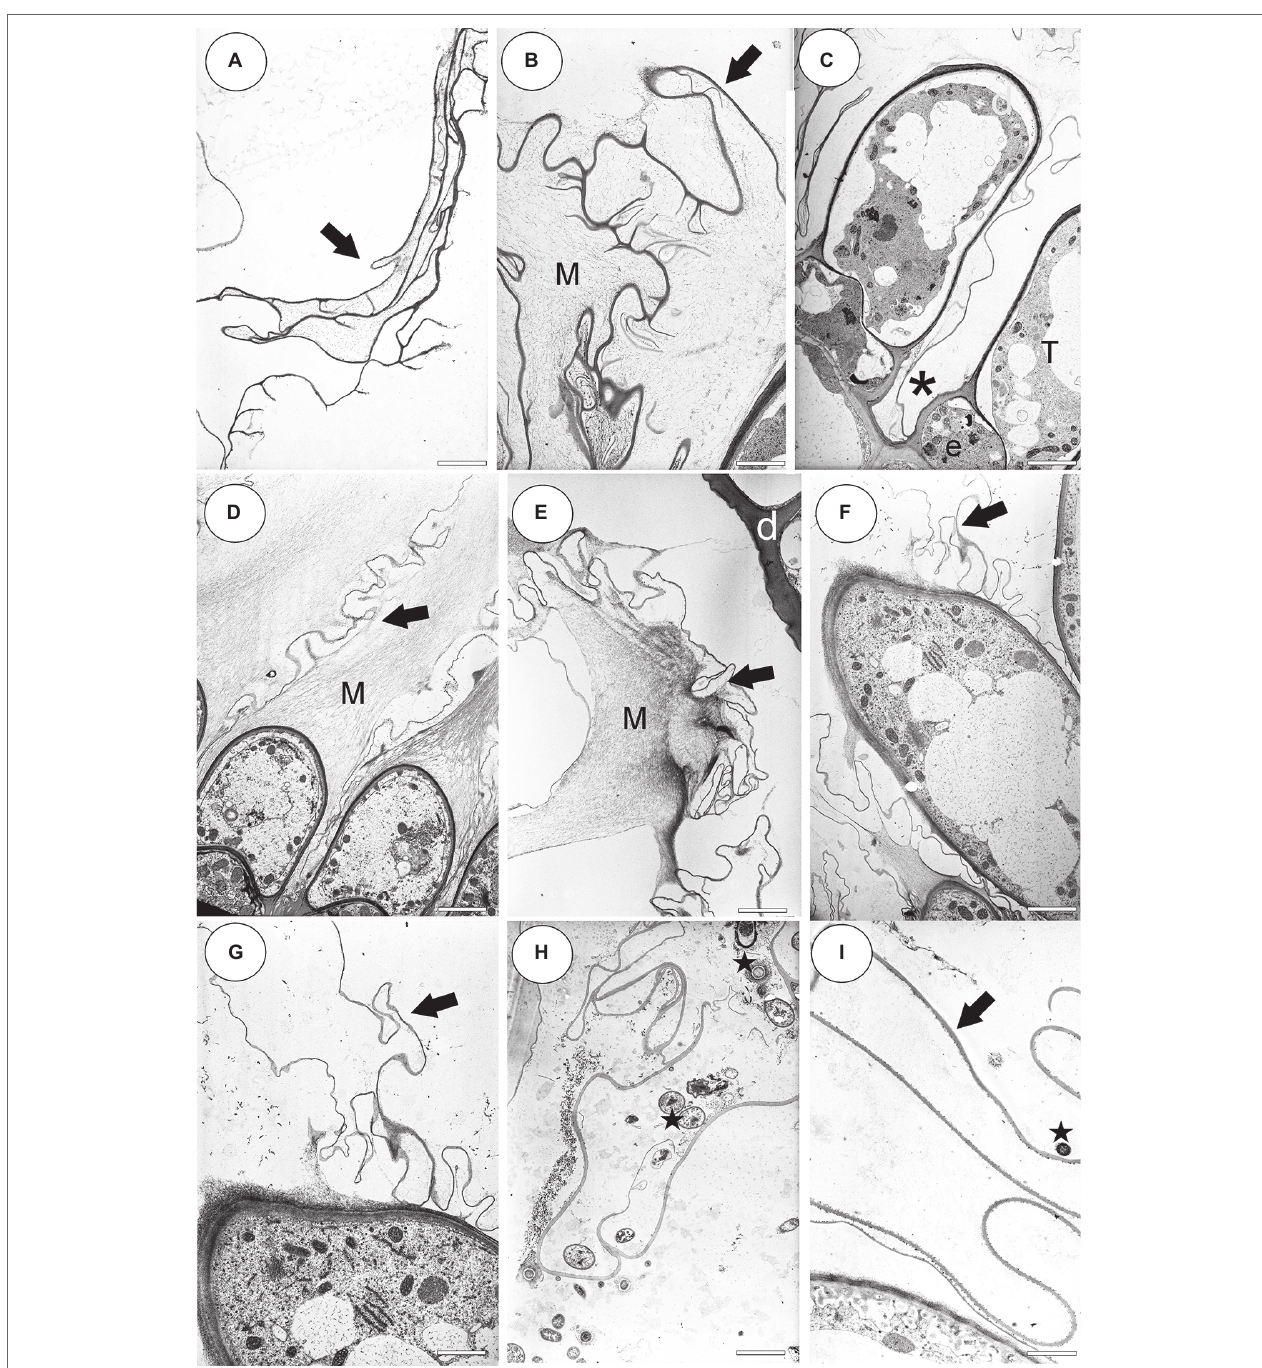
FIGURE 9 | Ultrastructure of the velum and pavement epithelium trichomes. (A) An external velum (arrow) ultrastructure of Utricularia dichotoma ; this part of the velum was formed by the cuticles of the threshold trichomes; scale bar = 1.92 μ m. (B) External velum (arrow) ultrastructure of Utricularia dichotoma , note the mucilage (M); scale bar = 1.92 μ m. (C) Ultrastructure of the pavement epithelium trichomes of Utricularia dichotoma , note that the velum was formed by the cuticles (asterisk) of the terminal cells (T) and also the middle (barrier) cells of the trichomes (e); scale bar = 3.66 μ m. (D) Ultrastructure of the velum (arrow) and pavement epithelium trichomes of Utricularia uniflora , note the mucilage (M); scale bar = 4 μ m. (E) Velum (arrow) ultrastructure of Utricularia uniflora , note the mucilage (M); scale bar = 3.14 μ m. (F,G) Velum (arrow) formation in Utricularia prehensilis , note that mucilage was also secreted; scale bar = 3.6 μ m and bar = 2.55 μ m. (H) Velum (arrow) ultrastructure of Utricularia nelumbifolia , note the bacteria (star); scale bar = 3 μ m. (I) Velum (arrow) ultrastructure of Utricularia reflexa , note the bacteria (star); scale bar = 2.55 μ